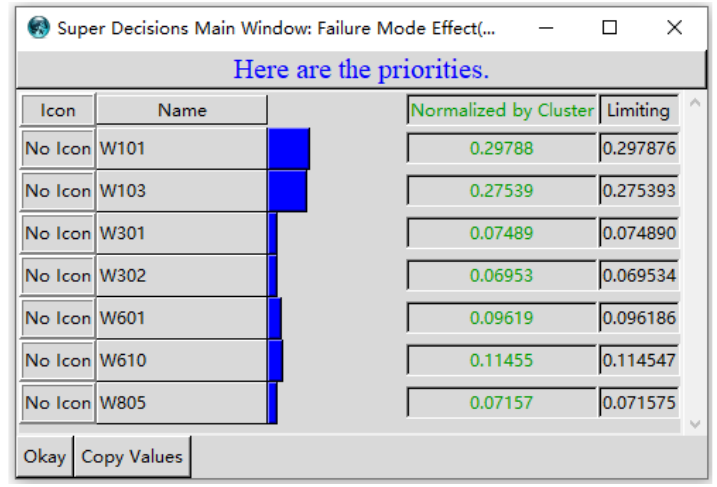
Figure 9. The failure mode influence degree of the cooling system.